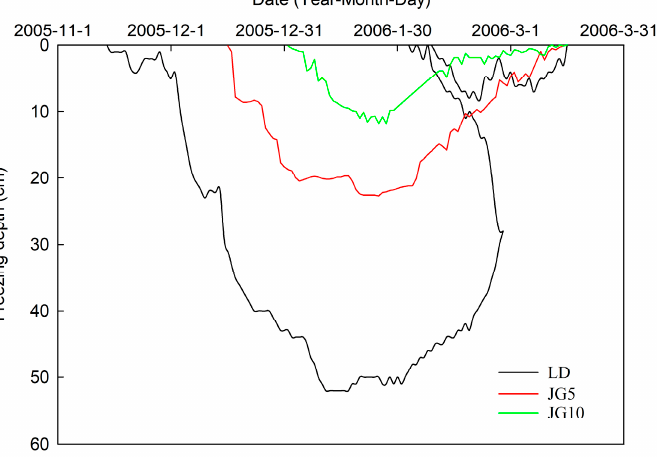
Figure 6. Soil freezing and thawing processes during the experimental period.